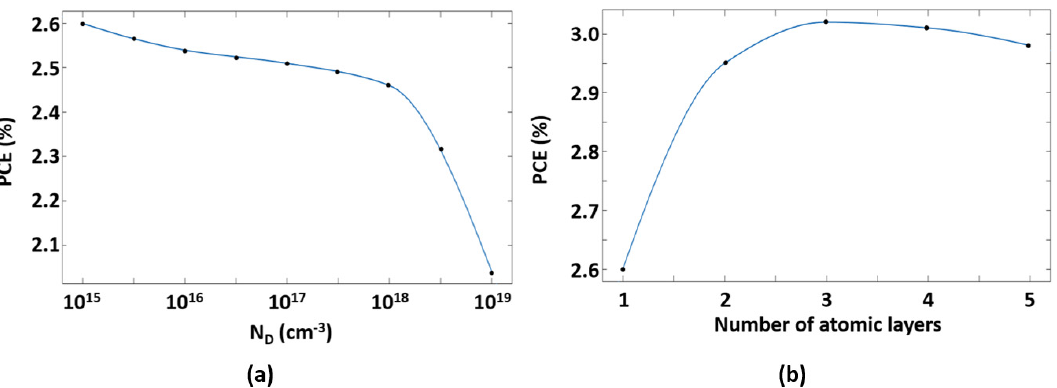
Figure 5. ( a ) Power conversion efficiency (PCE) dependence on N D for the monolayer graphene/n-Si junction with H = 10 μ m. ( b ) PCE dependence on the number of graphene atomic layers forming the graphene sheet, H = 10 μ m and N D = 10 15 cm − 3 .